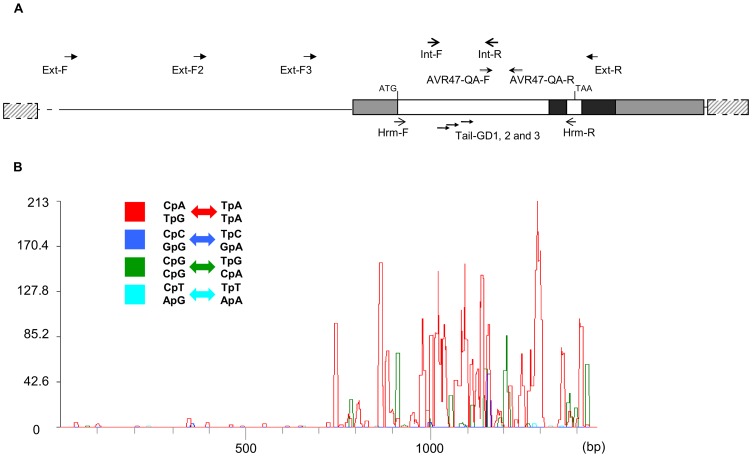
Schematic representation of the AvrLm4-7 gene and RIPCAL analysis of 127 RIPped AvrLm4-7 alleles.
A. The AvrLm4-7 sequence analysed (encompassing ca. 550 bp of the promoter region and ca. 60 bp of the 3′UTR) and the location of primers used for PCR and sequencing (primers Ext-F, Ext-R, Ext-F2 and Ext-F3, Int-F and Int-R), qRT-PCR (AVR47-QA-F and AVR47-QA-R), TAIL-PCR (Tail-GD1-Tail-GD3) and HRM analyses (Hrm-F and Hrm-R) are shown. White boxes, coding sequence; black boxes, introns; grey boxes, 5′ and 3′ UTR; hashed boxes, transposable elements. B. The alleles were identified in virulent avrLm7 isolates obtained in 2006 to 2008 from the experimental field at Grignon. The sequence with the greatest total G+C content (v23.1.2) was chosen as the least RIP-mutated model for comparison of all aligned sequences. Physical distribution of RIP along the AvrLm4-7 gene is illustrated by the overall RIP mutation frequency over a 50 bp scanning window. A substantial over-representation of the CpA/TpG↔TpA mutation (red) over CpN↔TpN or NpG↔NpA mutations (blue and green curves) was observed.